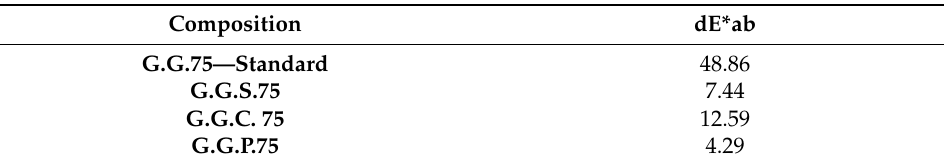
Table 11. Color changes of samples subjected to thermo-oxidative aging.